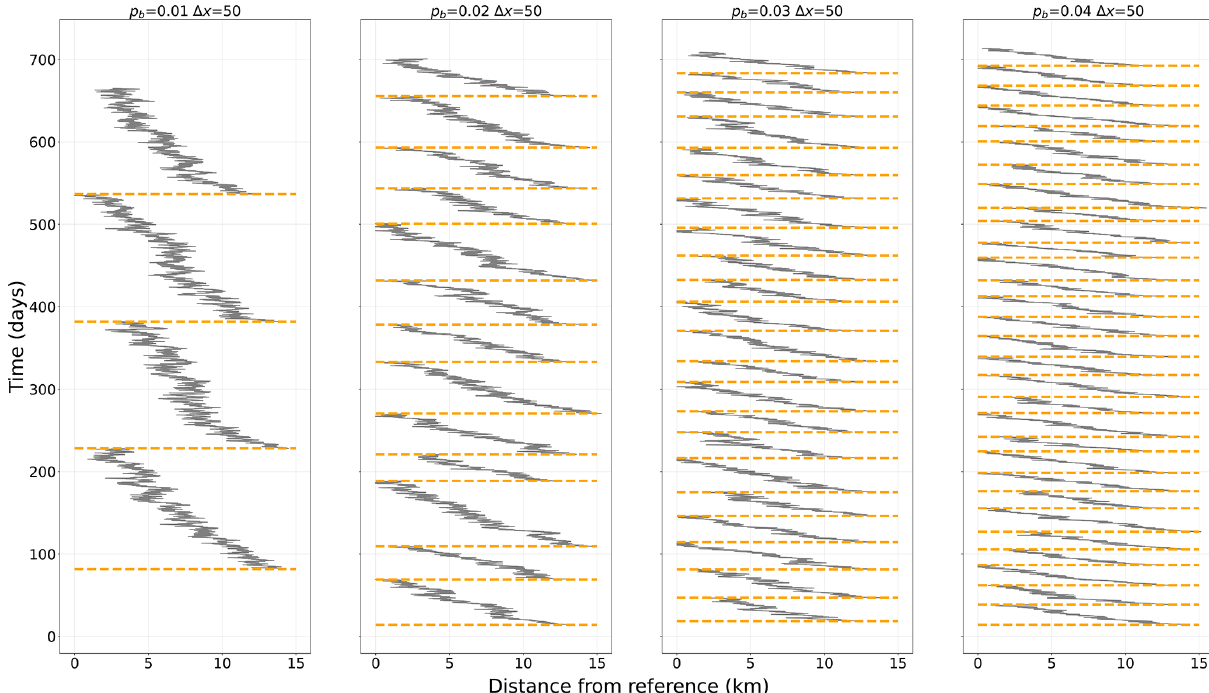
Figure 8. Along-fjord propagation of IMW fronts as modeled by BRIMM. In each panel a different value of the random bias p b is used.